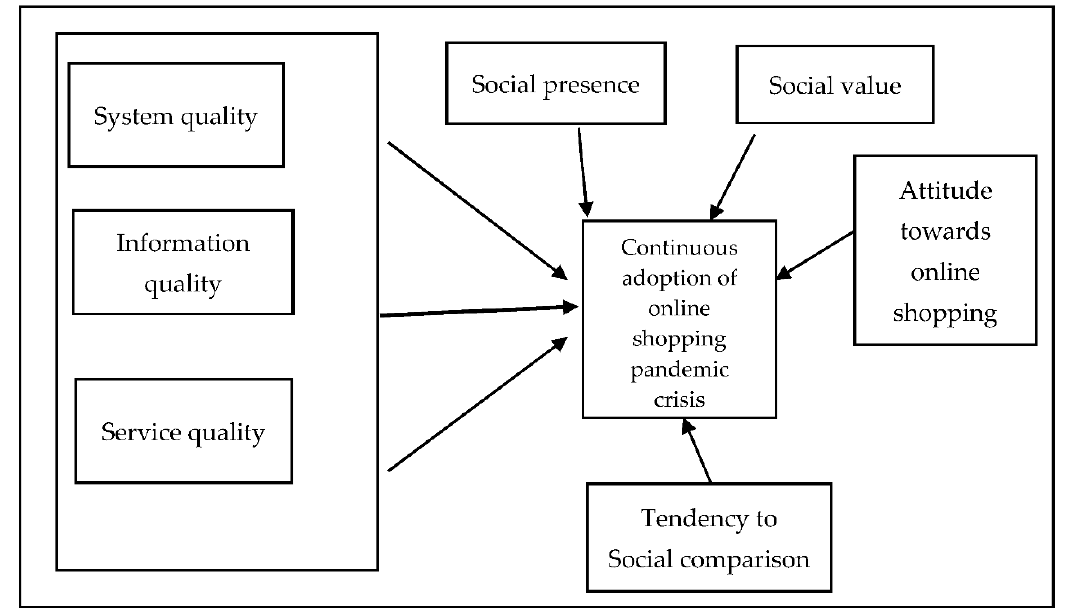
Figure 1. Proposed model for continuous adoption of on-line shopping after COVID-19.